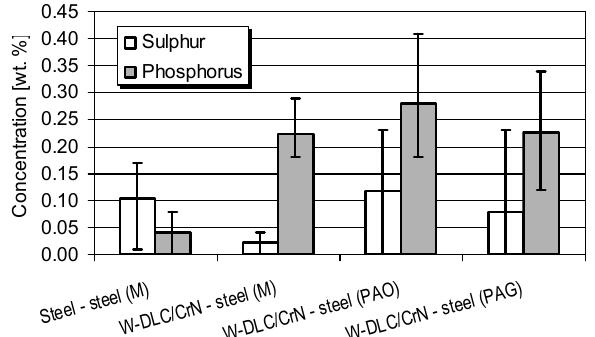
Figure 18. Quantitative results of the EDS analysis of sulfur and phosphorus from the worn surfaces of the test cones.